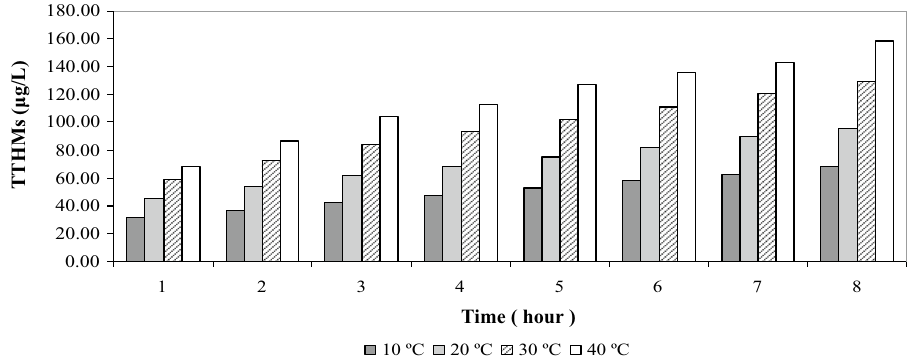
Fig. 1 Effect of contact time and temperature on the forma- tion of total trihalomethanes